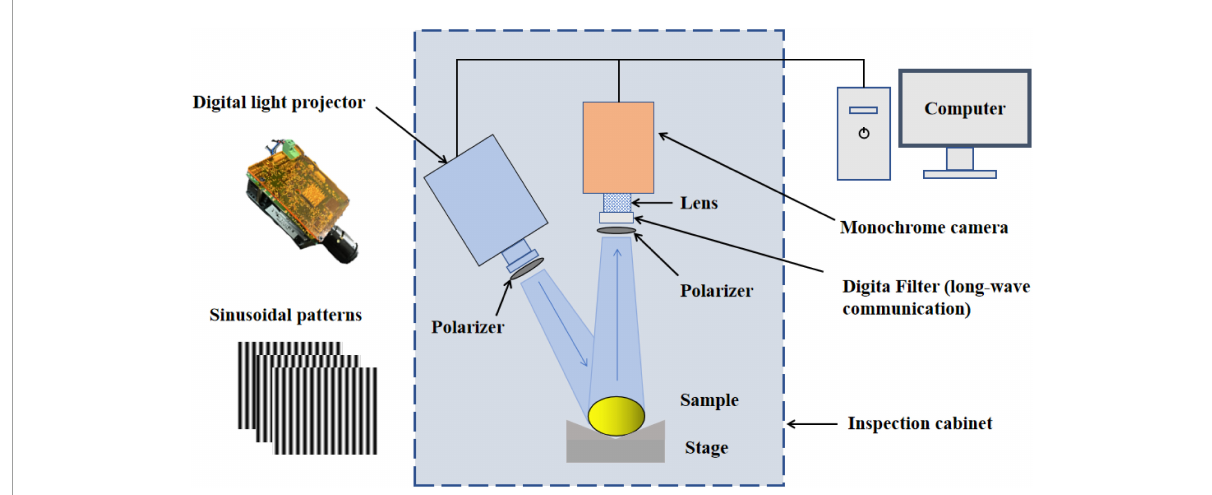
FIGURE2 Schematic diagram of the developed structured-illumination reflectance imaging (SIRI)